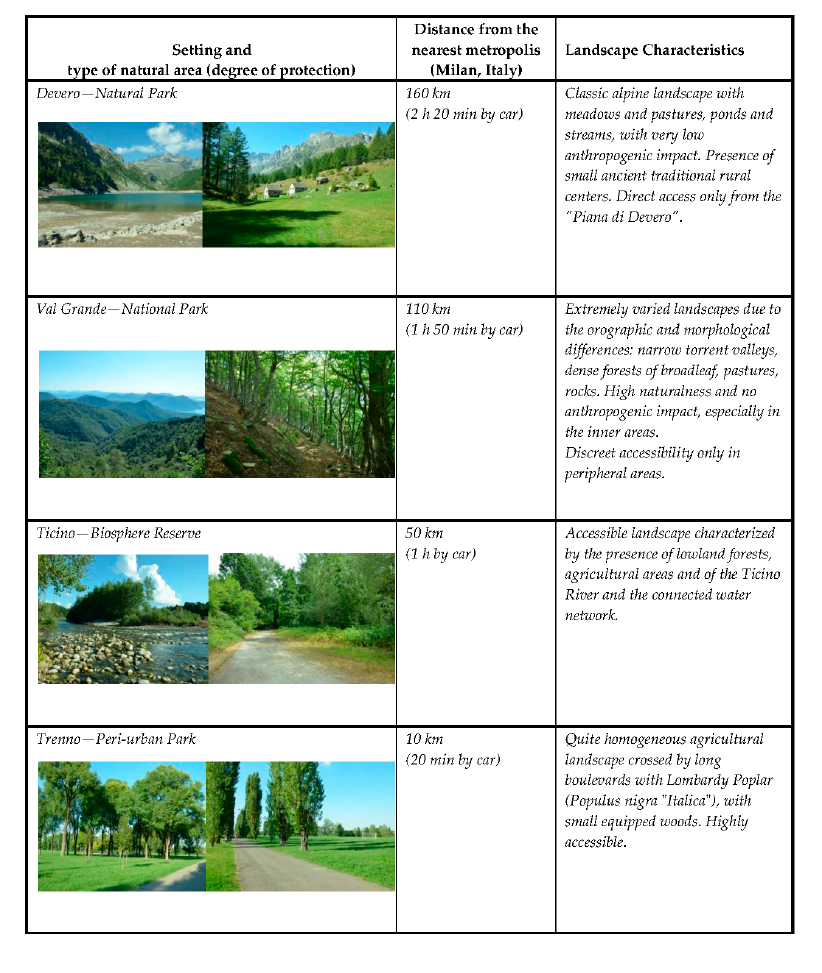
Figure 2. Description of the four settings.